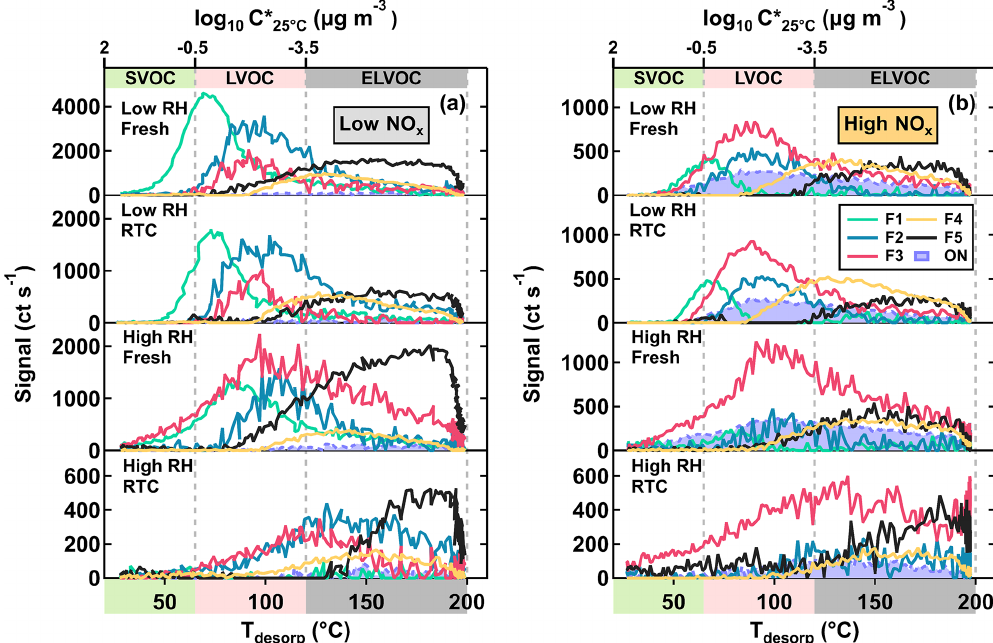
Figure 3. Factor thermograms of the five sample factors from the 12-factor PMF solution of CHO compounds in α -pinene SOA particles that were formed under low NO x (a) and high NO x (b) conditions in the OFR. In addition, thermograms of the sum of ONs (sum of NF1–3) are shown as purple areas in panel (b) . In both panels, the ranges of different volatility classes are highlighted as color bands on the